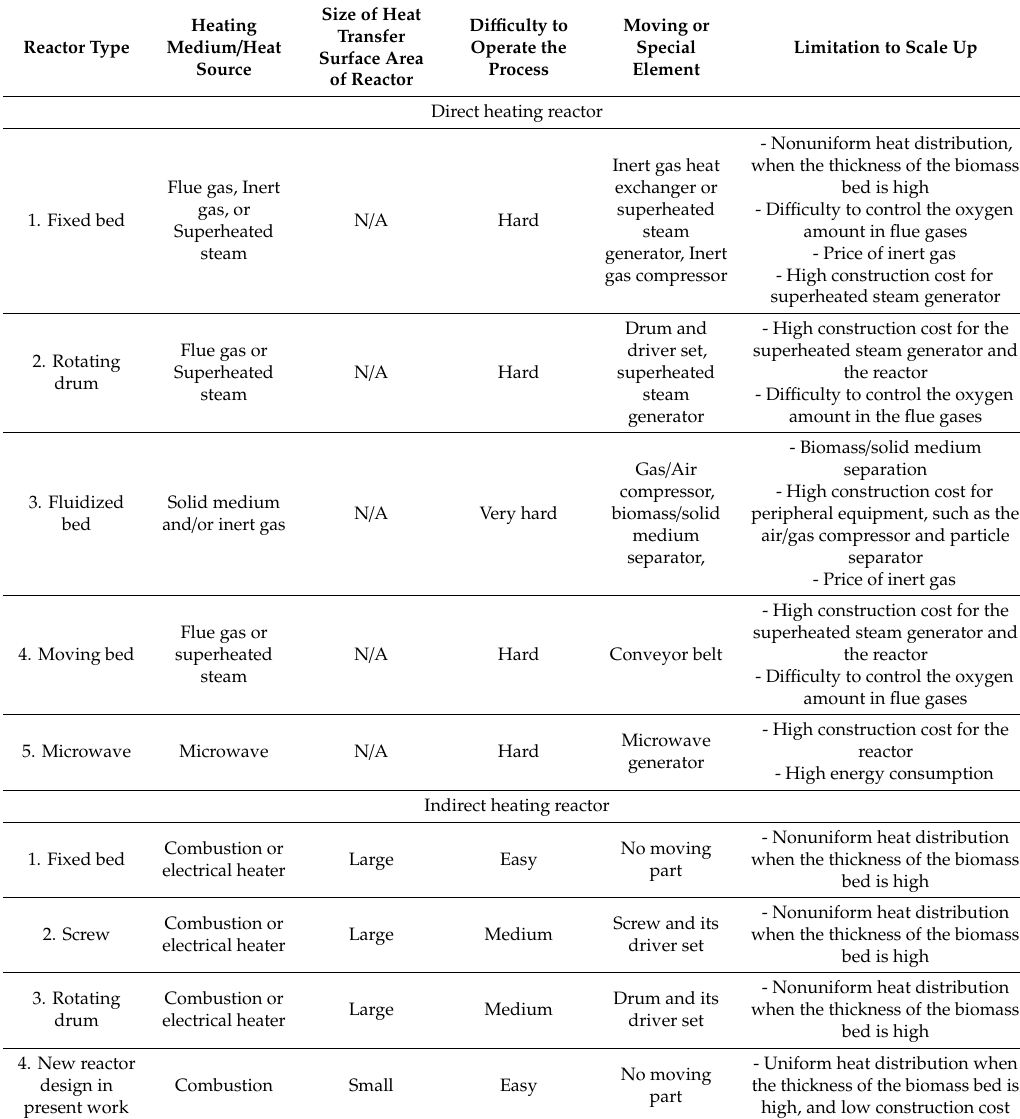
Table 1. Comparison of each